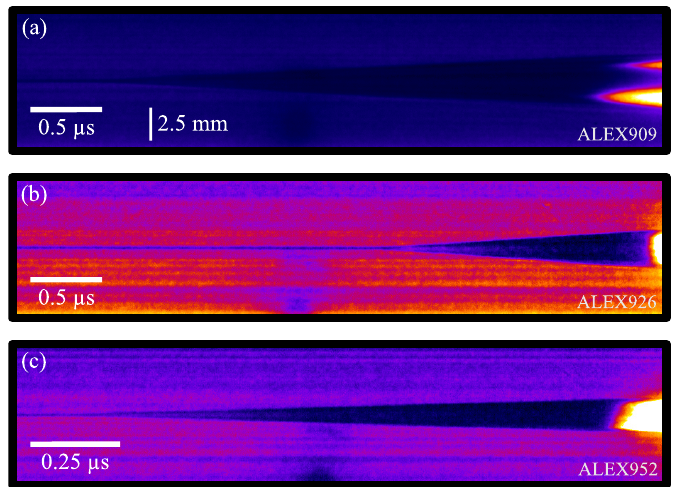
Figure 4. (Color online) typical platinum streak images at ( a ) 10 kV, ( b ) 15 kV and ( c ) 20 kV of charging voltage in the capacitors bank. Notice the different times scale in the last case. Space (vertical dimension) scale is the same in all the